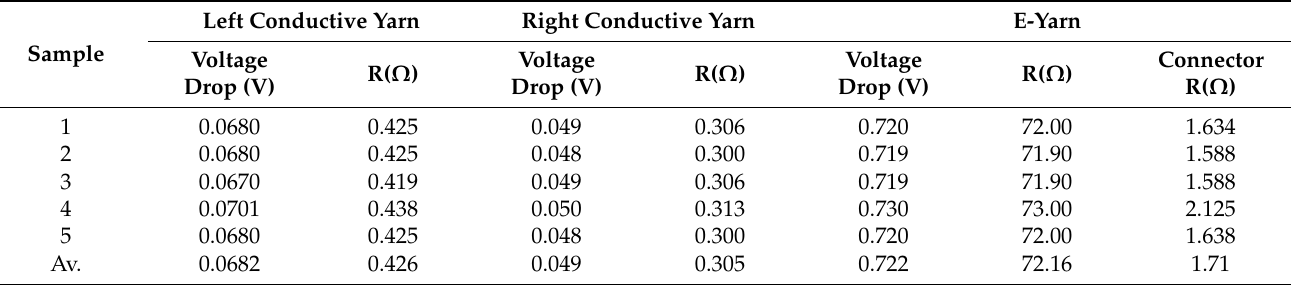
Table 4. Total electrical resistance of